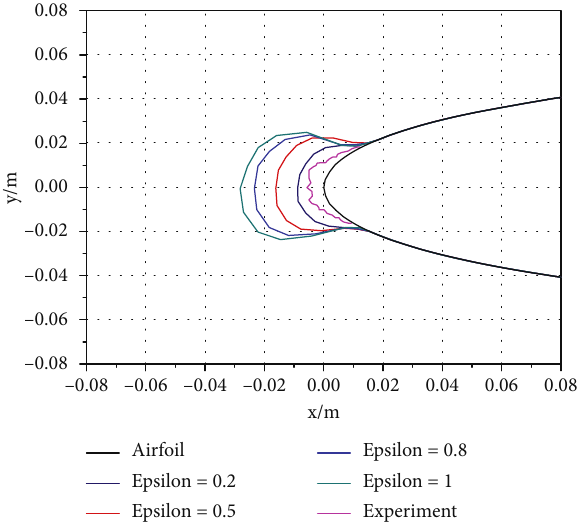
Figure 8: Comparison of ice shapes for di ff erent adhesion coe ffi